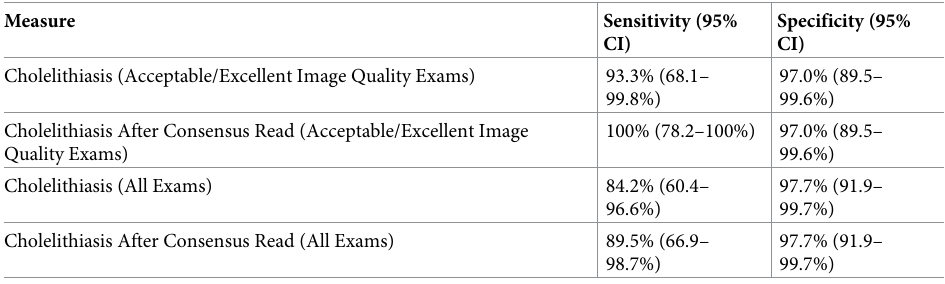
Table 3. Sensitivity/Specificity for